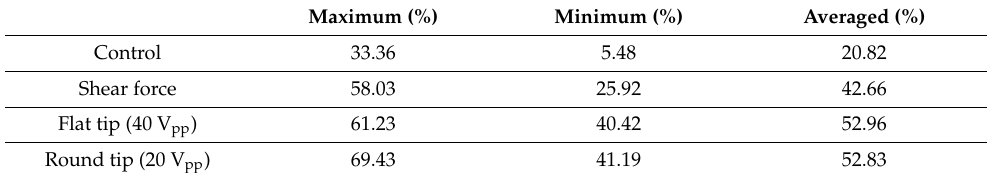
Table 2. Summary of chondrogenesis ratios in control and contrast groups.